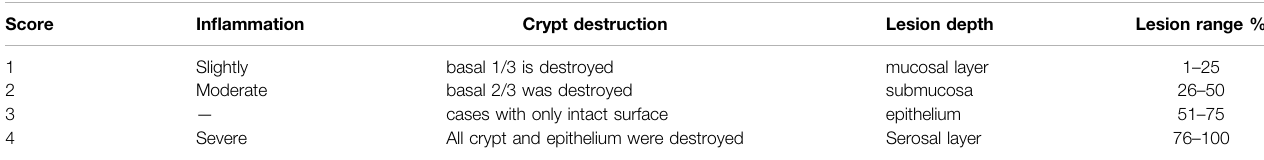
TABLE 2 | Histopathological score of